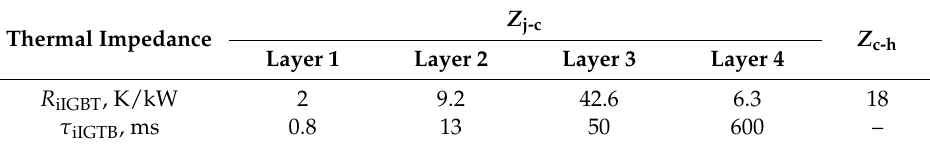
Table 2. Thermal impedances of the FZ400R17KE4 IGBT module.